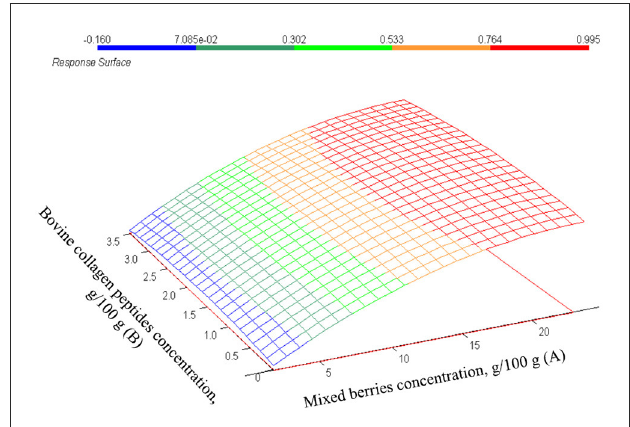
FIGURE8 The estimated values of total polyphenol content. g/L in function of mixed berries concentration (A) and bovine collagen peptides concentration (B).